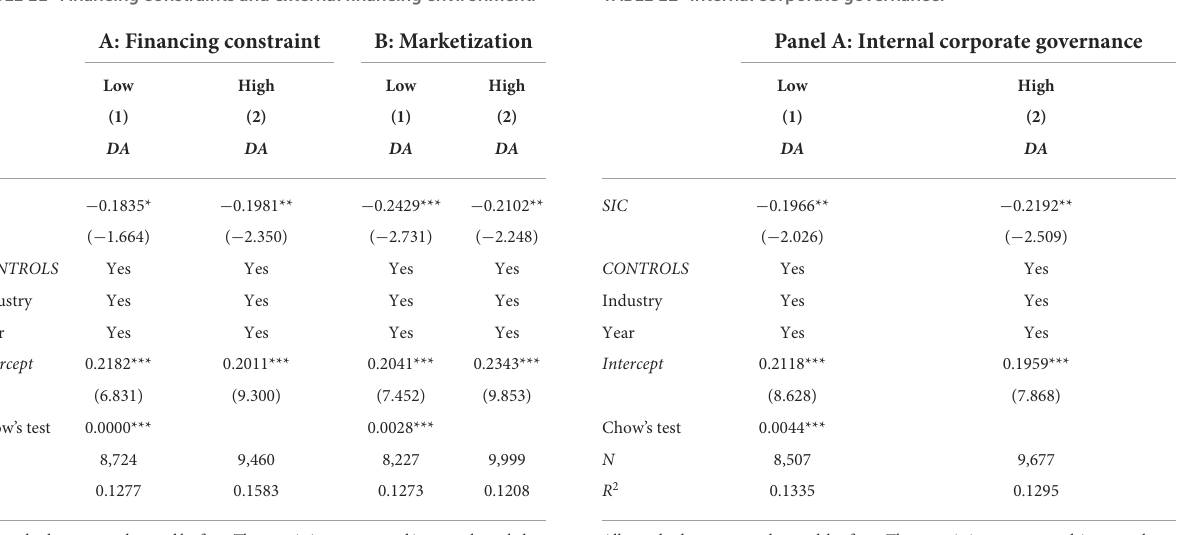
TABLE 11 Financing constraints and external financing